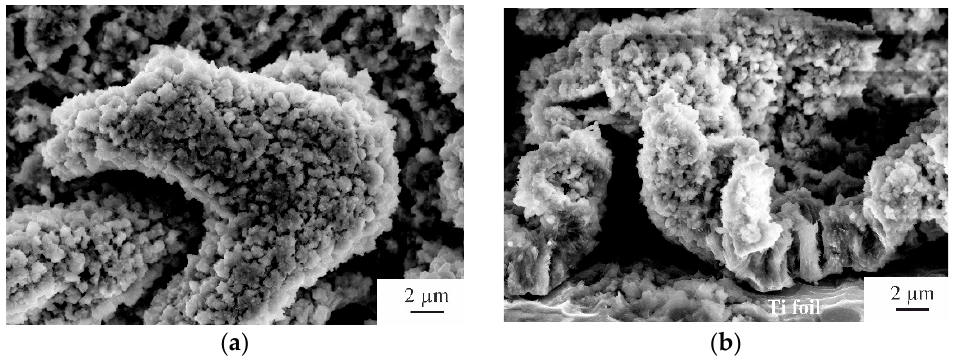
Figure 7. SEM images of the surface morphology ( a ) and cross-section ( b ) of the samples after long cycling in the electrolyte solution with VC.